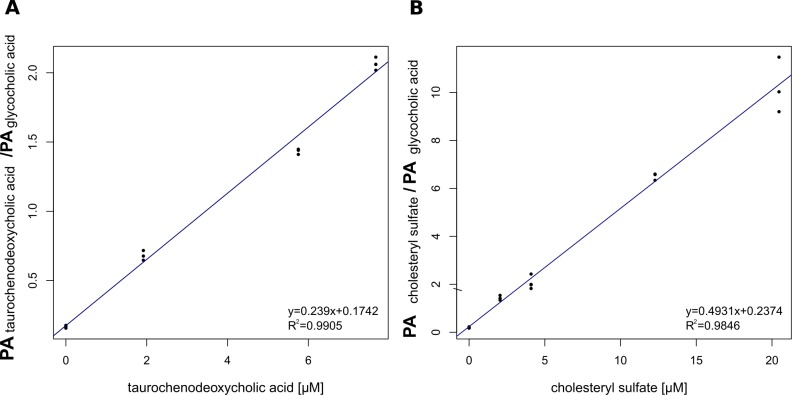
Calibration curves after ESI-MS of (A) taurochenodeoxycholate (TCDCA) and (B) cholesteryl sulfate used for the quantification of 5α-cyprinol sulfate.The detected peak areas (PA) of cholesteryl sulfate and TCDCA normalized to the detected peak areas of glycocholic acid (internal standard) are plotted against the respective concentrations.10.7554/eLife.44791.016Figure 4—figure supplement 3—source data 1.Calibration curves of taurochenodeoxycholate and cholesteryl sulfate.